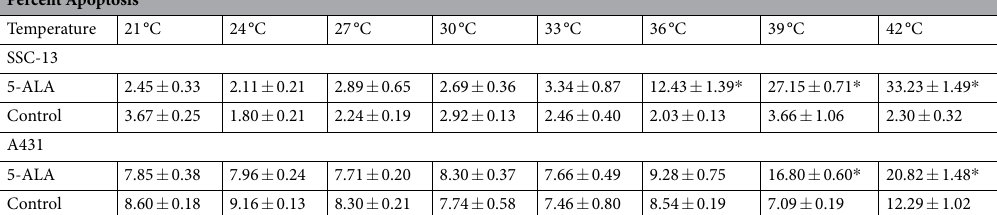
Table 3. Percent apoptosis of 5-ALA and control samples incubated at variable temperatures. Abbreviations: 5-ALA – 5-aminolevulinic acid. P < 0.05 denoted by asterisk. ( *